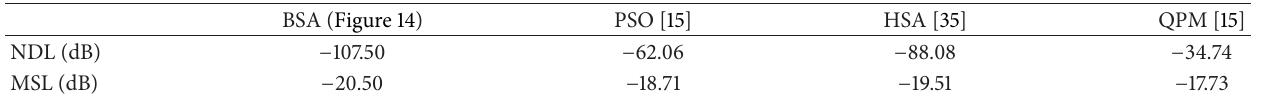
Table 8: NDL and MSL values obtained by BSA and other optimization techniques PSO [15], HSA [35], and QPM [15] for 32-element linear antenna array with imposed one null at 9 ∘ .